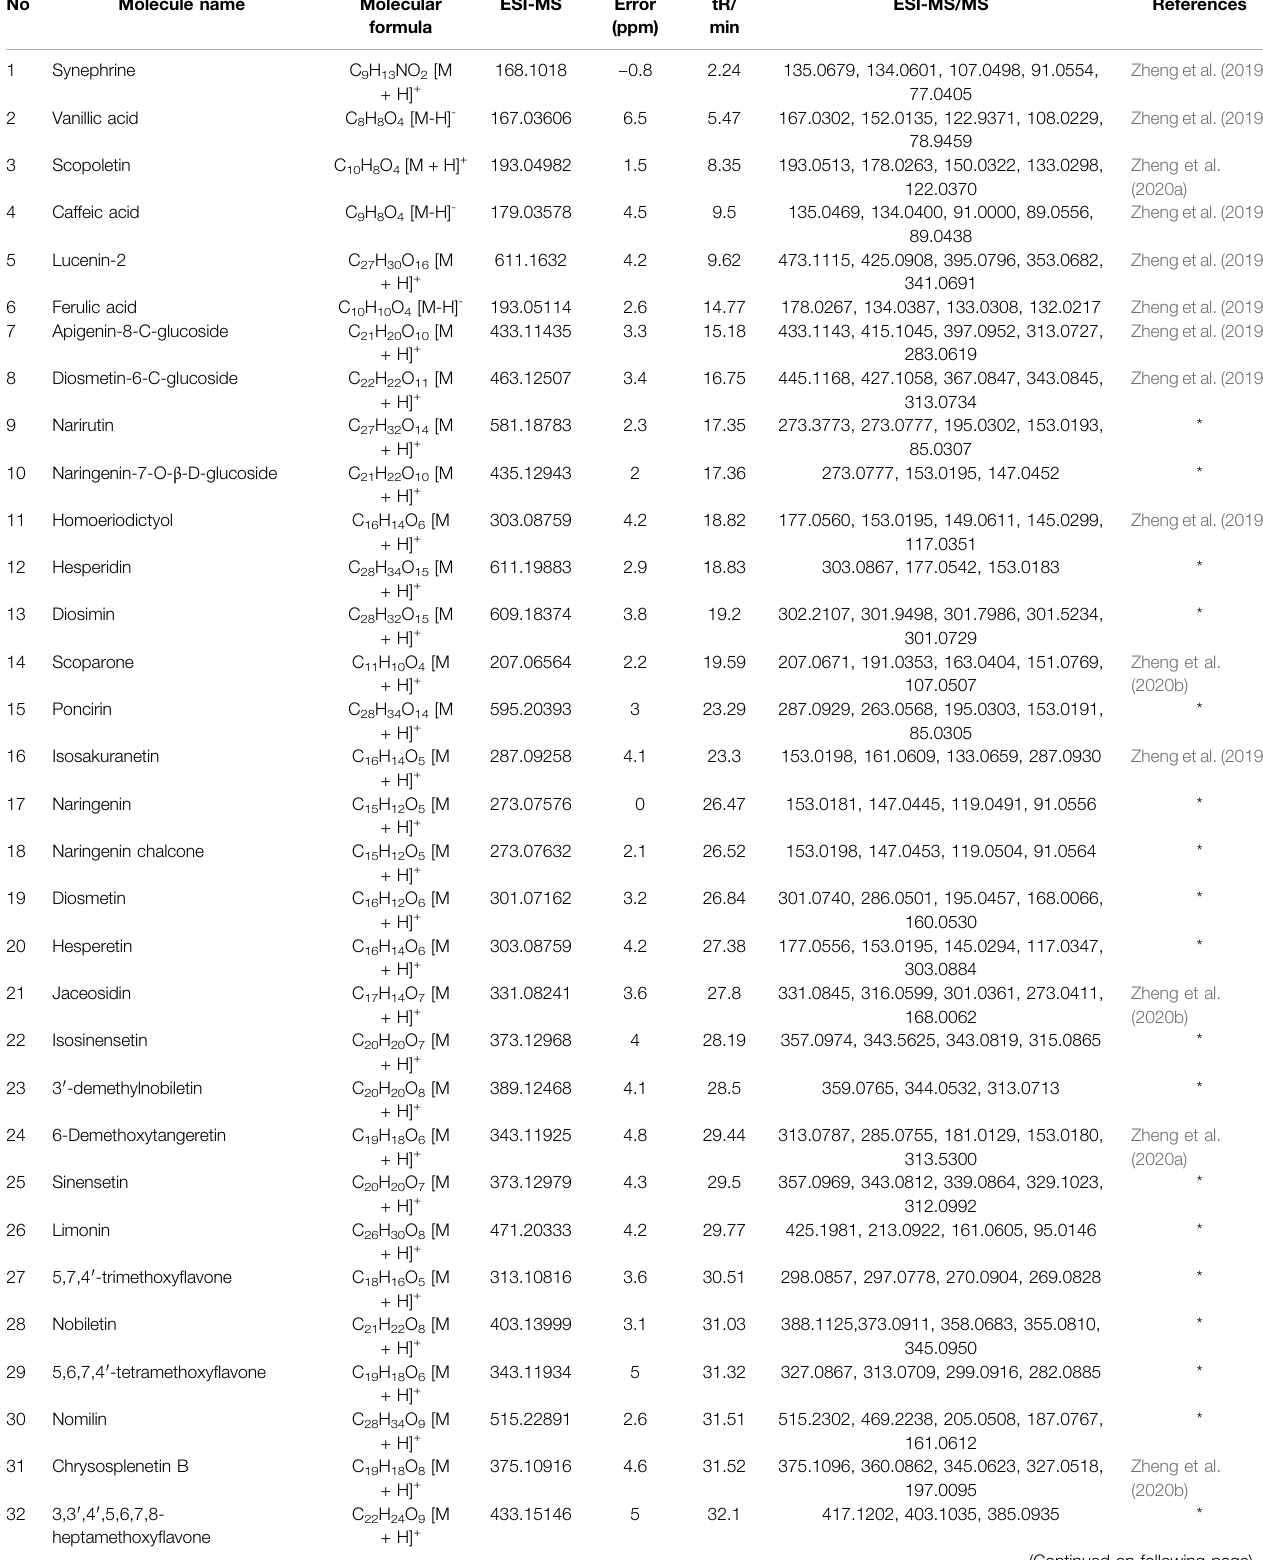
TABLE 1 | CRP compounds identi fi ed by